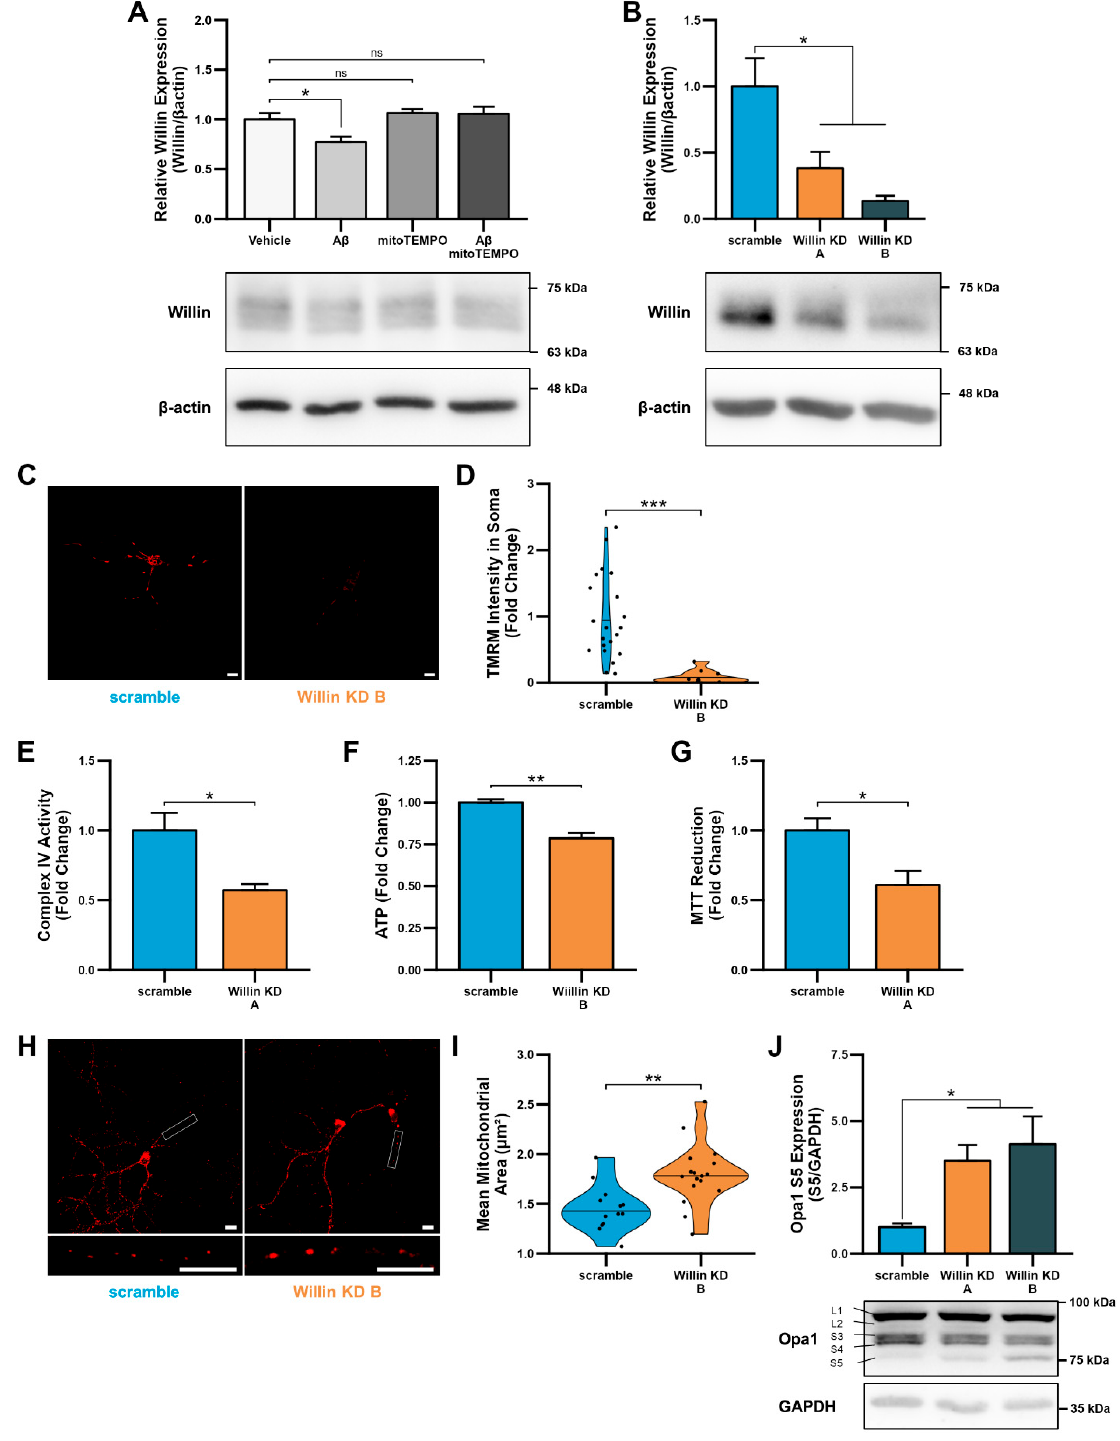
Figure 5. Downregulation of Willin/FRMD6 induces mitochondrial dysfunction in primary mouse neurons. ( A ) Primary mouse cortical neurons (DIV 10) were exposed to 0.5 μ M A β in 0.5× B-27 for 24 h with or without 10 μ M mitoTEMPO pretreatment (1 h) and then subjected to immunoblot analysis for Willin/FRMD6 expression. β -actin served as a protein loading control. Upper panel represents quantification of immunoreactive bands relative to β -actin. Data are expressed as fold change relative to the vehicle group. Representative immunoblots are shown underneath. n = 3 per group. * p < 0.05. ns = not significant. ( B ) Densitometry of Willin/FRMD6 immunoreactive bands in lysates from control (scramble) and Willin/FRMD6 knockdown (Willin KD A and Willin KD B) cortical neurons (DIV 15). β -actin served as a protein loading control. Upper panel represents quantification of immunoreactive bands relative to β -actin. Data are expressed as fold change relative to the scramble control group. Representative immunoblots are shown underneath. n = 4-5 per group. * p < 0.05. ( C , D ) Mitochondrial membrane potential was measured by TMRM staining intensity. ( C ) Representative images of TMRM staining in primary hippocampal neurons. Scale bar = 10 μ m. ( D ) Quantification of soma staining intensity for TMRM using NIH ImageJ. n = 9-22 neurons per condition. Dots represent individual neurons. *** p < 0.001. ( E ) Enzymatic activity of cytochrome c oxidase (mitochondrial complex IV) was determined in cell lysates from cortical neurons from the indicated groups. n = 3 per group. * p < 0.05. ( F ) ATP levels in cortical neurons were measured by luciferase assay in the indicated groups. n = 4 per group. Data are expressed as fold change relative to the scramble group. ** p < 0.01. ( G ) Mitochondrial redox capacity measured by MTT reduction assay in cortical neurons. n = 6 per group. * p < 0.05. ( H , I ) Primary hippocampal neurons were labeled with anti-TOM20 for visualization of mitochondria morphology. ( H ) Representative images of TOM20 staining. Scale bar = 10 μ m. ( I ) Quantitative measurement of